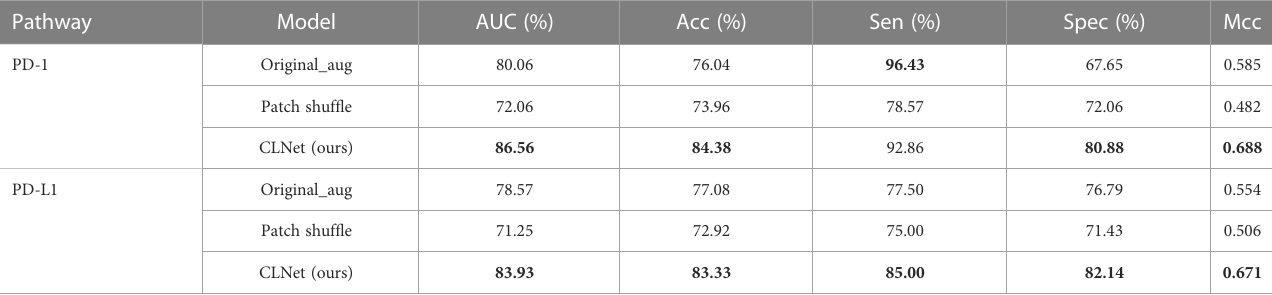
TABLE 5 Performance comparison among different data augmentation strategies for contrastive learning.